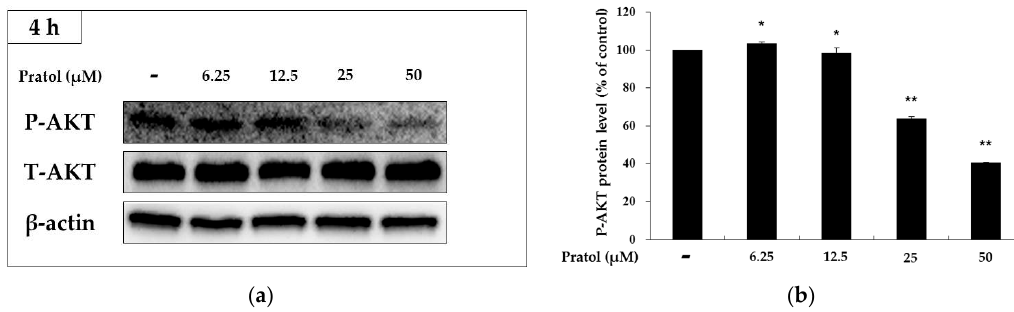
Figure 6. Effects of pratol on AKT phosphorylation. B16F10 cells were treated with various concentrations of pratol (6.25, 12.5, 25, or 50 μ M) for 4 h. ( a ) Protein expression levels were investigated by western blotting; ( b ) Results are expressed as a percentage of the control. The data are presented as mean ± SD of at least three independent experiments. * indicates p < 0.05, whereas ** indicates p < 0.01. P: Phosphorylated, T: Total.